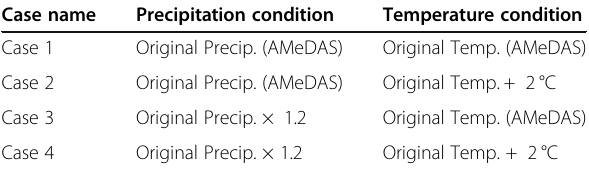
Table 1 Study cases under various weather